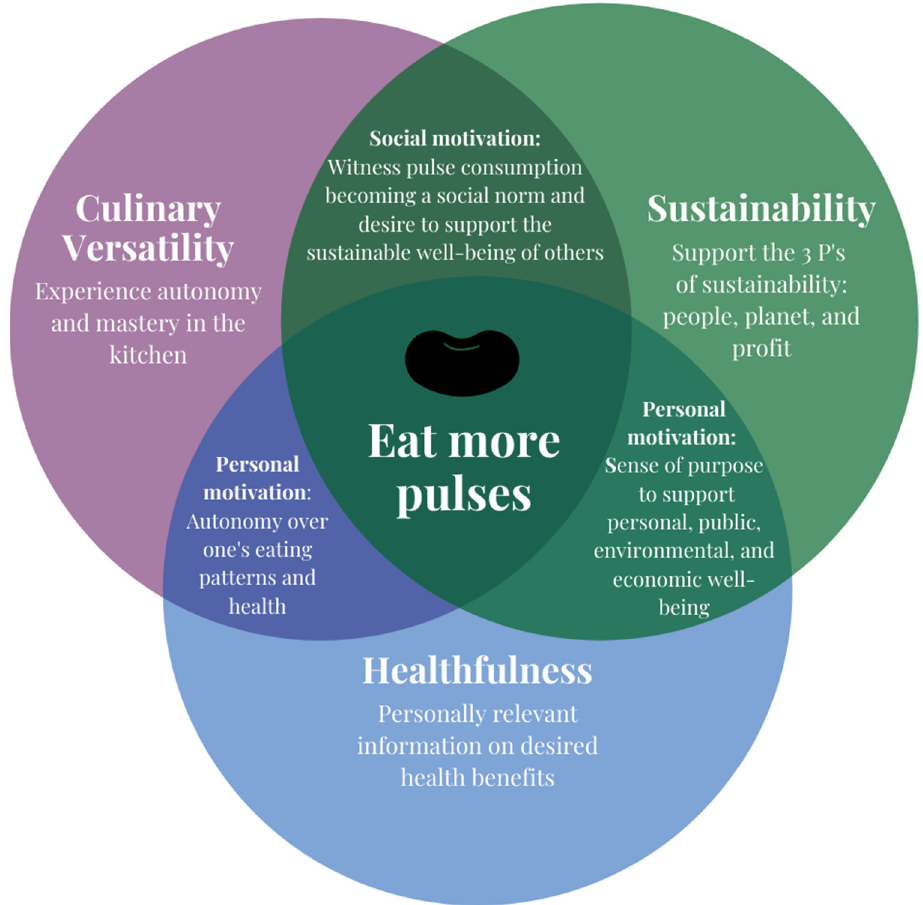
Figure 1. Emphasizing the culinary versatility, sustainability, and healthfulness of pulses to drive social and personal motivation to increase consumption.